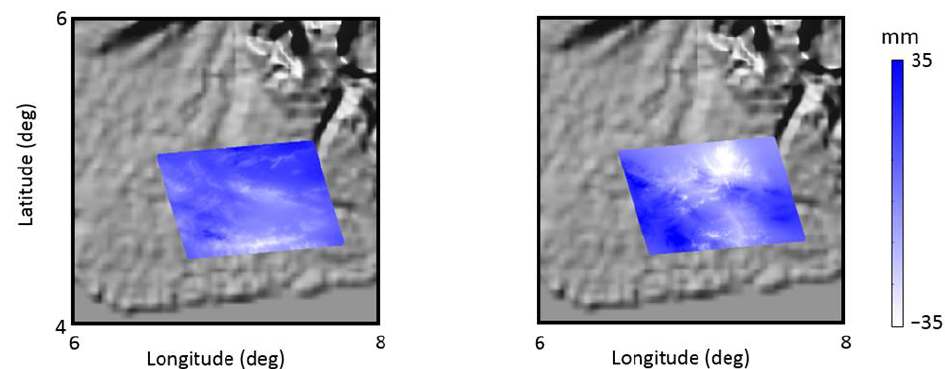
Figure 6. Samples of obtained APSs using the advanced integration method on different interfero- grams. ( Left ): 17 April 2015; ( right ): 19 January 2016.